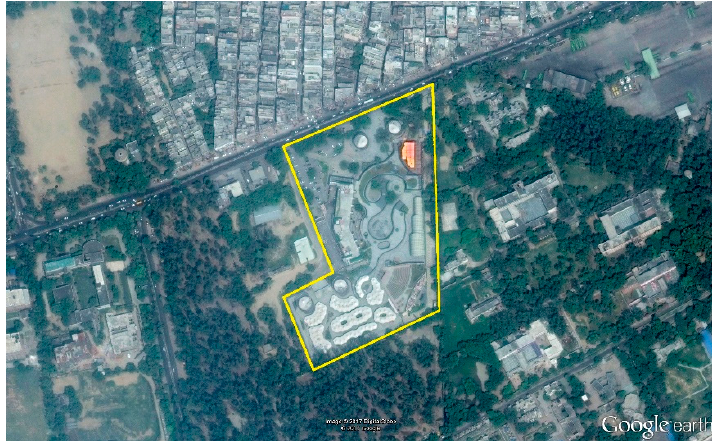
Figure 31. Satellite image of Dilli Haat Janakpuri (Image courtesy of Google Earth).